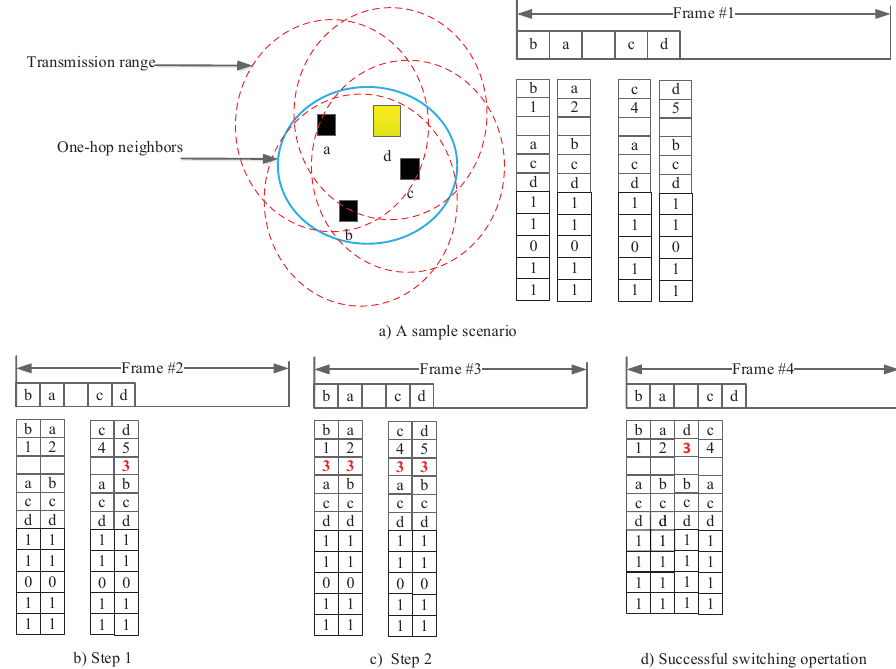
Figure 3. Operation of the adjustment scheme for node d. ( a ) each node periodically broadcasts its MANC packet; ( b ) Step 1: All one-hop neighbors successfully receive MANC packets, and node d , which occupies the last time slot #3, will consider a move to a new time slot. As node d can move to #3, it will include #3 in the switched time slot field of its MANC packet and broadcasts it in its reserved time slot, #5; ( c ) Node d checks the switched time slot fields of all MANC packets sent by its one-hop neighbors; ( d ) If all one-hop neighbors updated the information from node d , node d successfully acquires the new time slot, #3, reducing the length of the TDMA period in the next